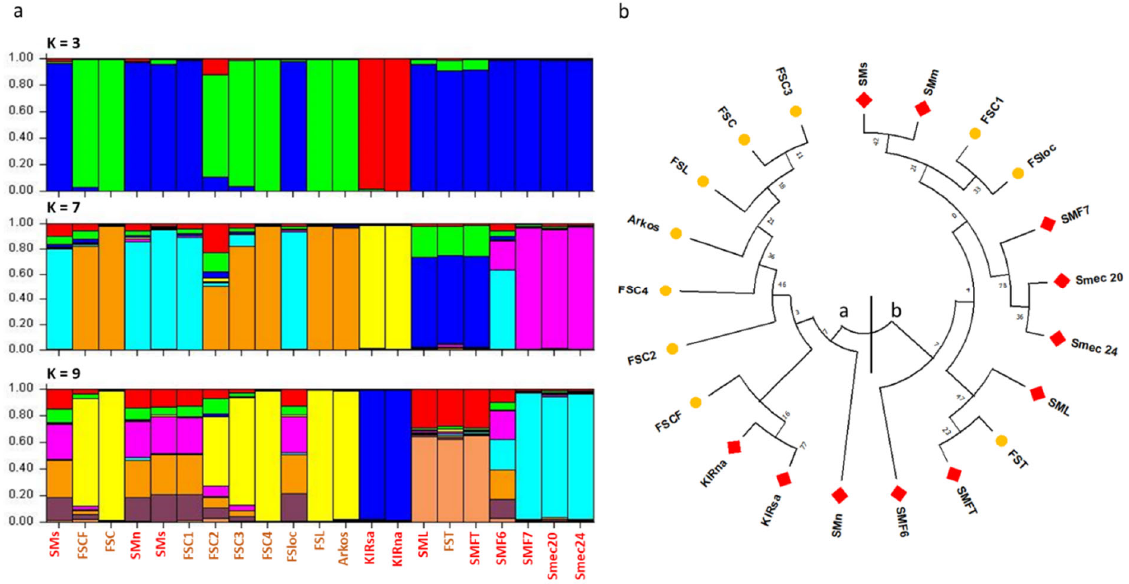
Figure 7. Genetic diversity of the collection studied based on polymorphisms detected with both capillary electrophoresis and high resolution melting using ten microsatellite markers. ( a ) STRUCTURE analysis of three (K = 3), seven (K = 7) and nine (K = 9) cluster. The vertical bars indicate the membership coefficient for each individual. Coloured blocks correspond to the different clusters. ( b ) Circular diagram showing maximum likelihood-based phylogenetic analysis based on Tamura-Nei